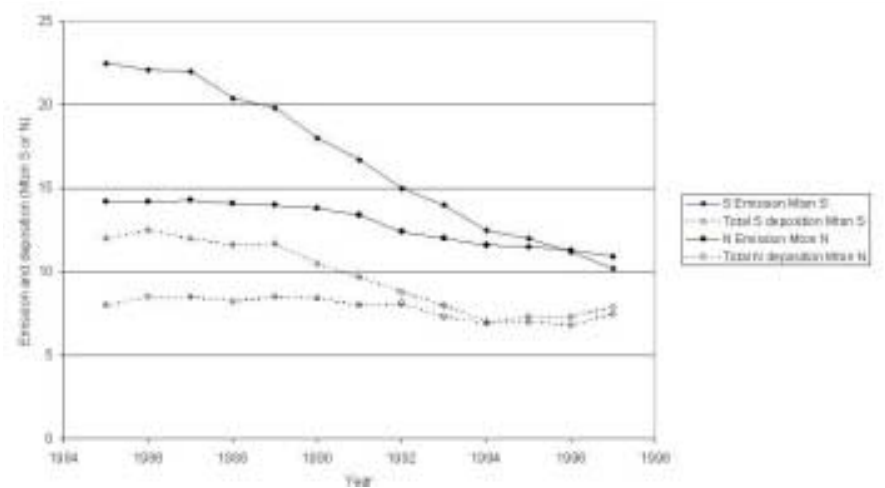
FIGURE 4. Total (modelled) deposition and estimated emission in Europe between 1985 and 1999 (Mton S or N per